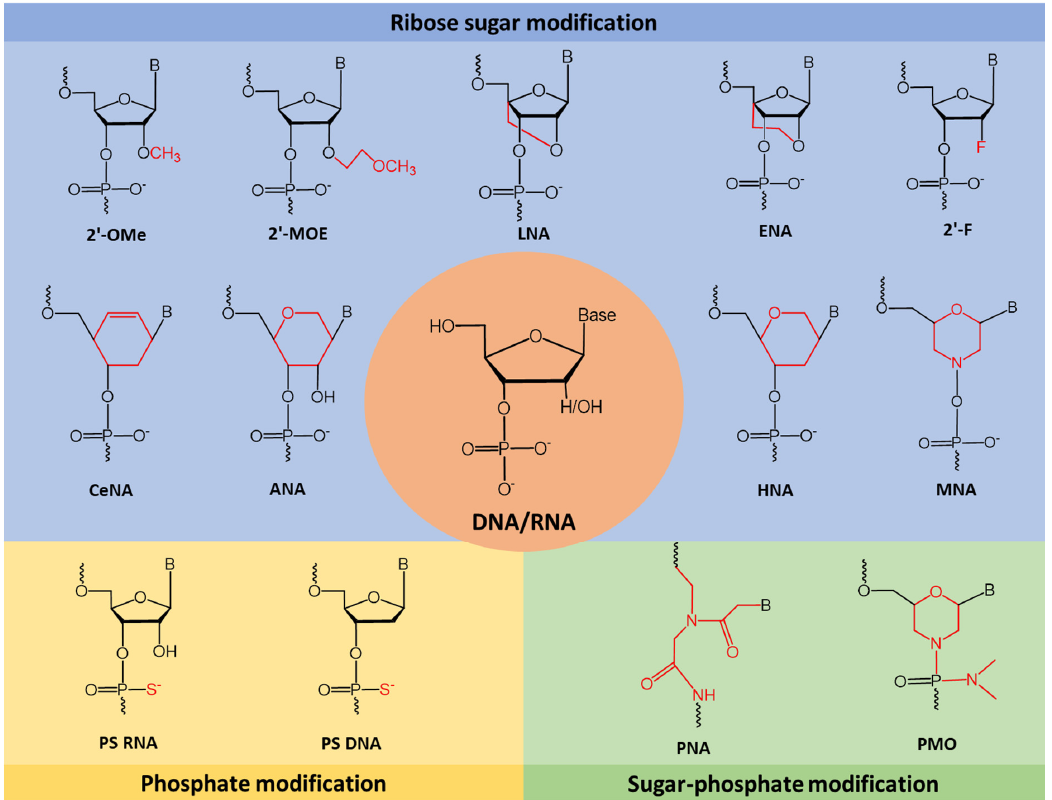
Figure 4. This figure depicts some of the most common or novel chemically modified nucleotide analogues used in constructing splice modulating AOs. 2 (cid:48) -OMe: 2 (cid:48) -O-methyl; 2 (cid:48) -MOE: 2 (cid:48) -O-methoxyethyl; LNA: locked nucleic acid; ENA: 2 (cid:48) -O, 4 (cid:48) -C-ethylene-bridged nucleic acid; 2 (cid:48) -F: 2 (cid:48) -fluoro; CeNA: cyclohexenyl nucleic acid; ANA: altritol nucleic acid; HNA: 1,5-anhydro hexitol nucleic acid; MNA: morpholino nucleic acid; PS: phosphorothioate; PNA: peptide nucleic acid; PMO: phosphorodiamidate morpholino